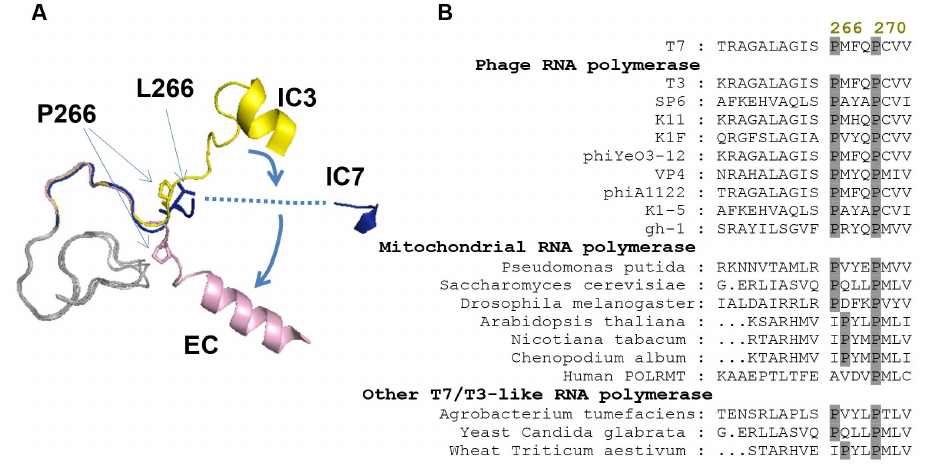
Figure 1. C-linker region of T7 RNAP. (A) The C-linker region (residues 251 to 296 in cartoon format) adopts different conformations in the initiation state (yellow, 1QLN, IC3), the elongation state (Pink, 1MSW, EC), and with 7 nt transcript bound (blue, 3E2E, IC7). The P266 and L266 residue is shown in stick format. The amino acids from 255 to 263 are disordered in the P266L structure (3E2E) and shown as dashed line. The direction of rotation of the linker near the hinge region is marked with arrows. The C-terminal domains (residues 300–883) of the three structures were aligned using Pymol (Molecular graphics systems). (B) Conservation of proline residue in the linker region between N-terminal domain and C-terminal domain at positions 266 and 270 in single-subunit RNAPs of phage, bacterium, and eukaryotic mitochondria. The N-terminal 1–300 amino acid sequence of T7 RNAP was used as a query in a BLAST amino acid search of the NCBI database for sequence alignment.